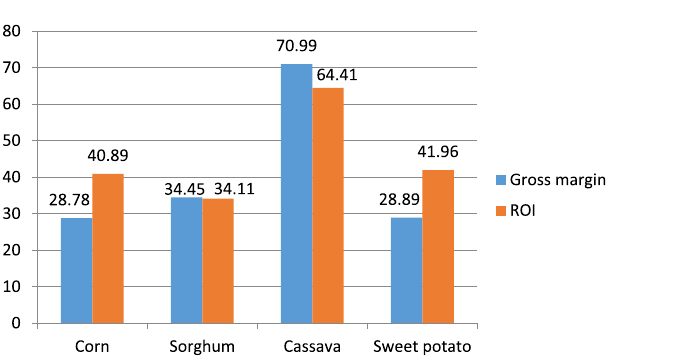
Figure 2. Gross margin and return on investment (ROI) of bioethanol produced selected starchy